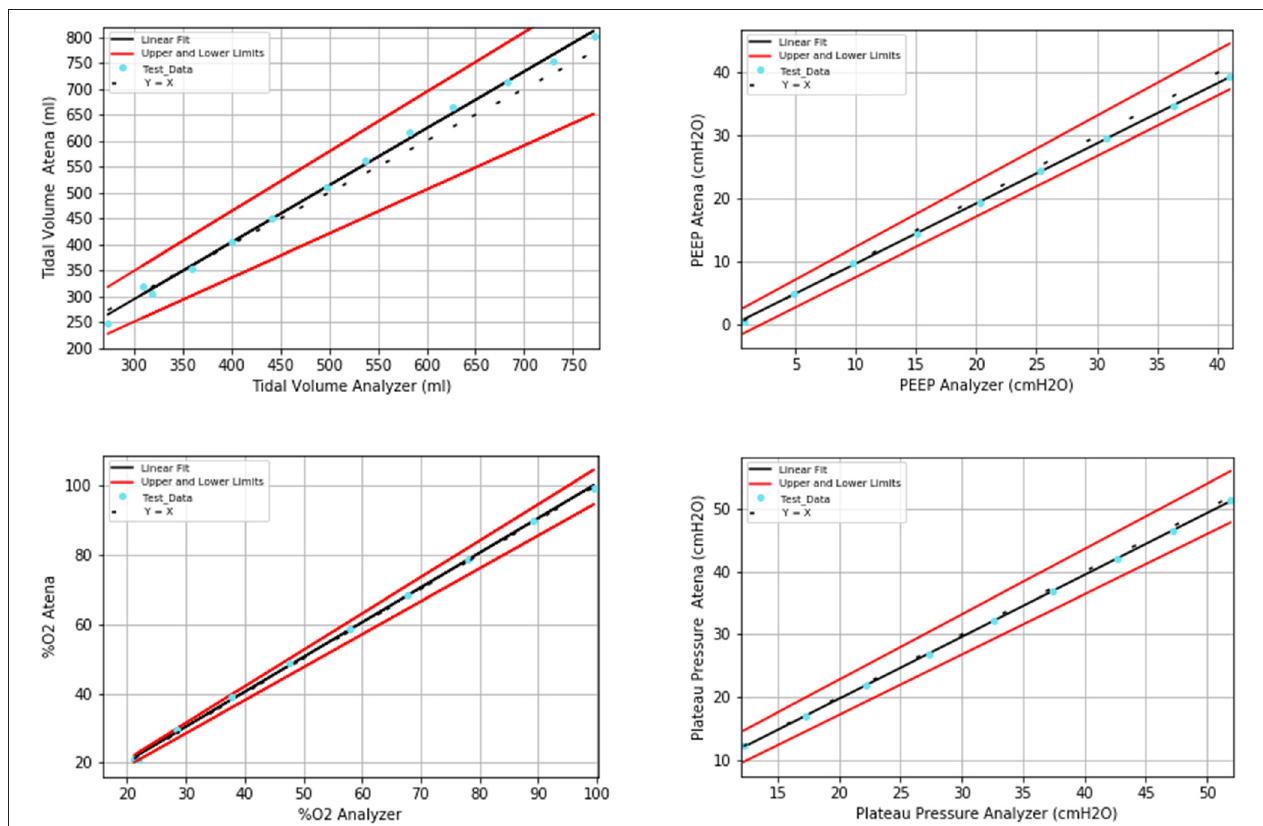
FIGURE 6 | Linear-fit results from additional tests for a wide range of settings (tidal volume, PEEP, FiO 2 , and plateau pressure,